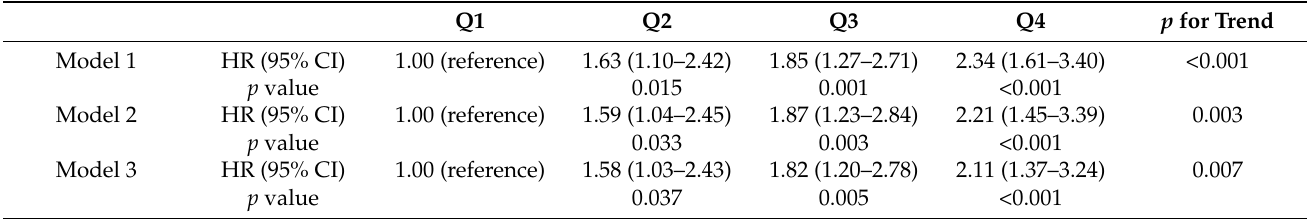
Table 4. Hazard ratios and 95% confidence intervals for new-onset ischemic heart disease (IHD) according to atherogenic index of plasma (AIP) quartiles.